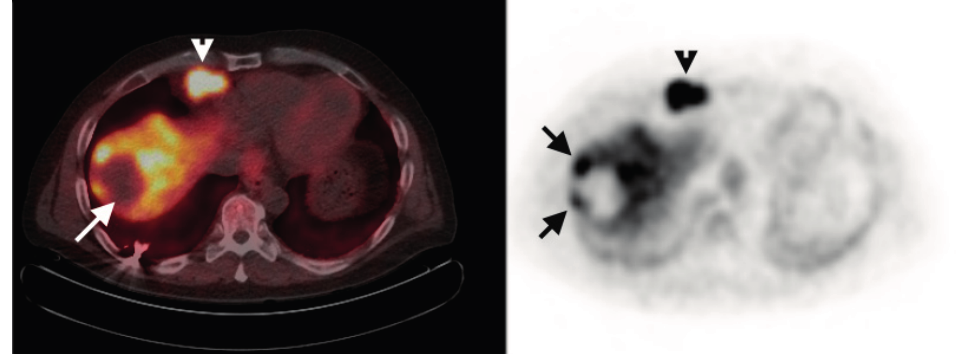
Figure 1. Multifocal recurrent hepatocellular carcinoma (HCC). Corresponding positron emission tomography (PET)/computed tomography (CT) ( left ) and PET ( right ) images demonstrate multiple foci of increased fluorocholine (FCh) uptake in the liver ( arrows ) ranging in diameter from 7 to 30 mm.